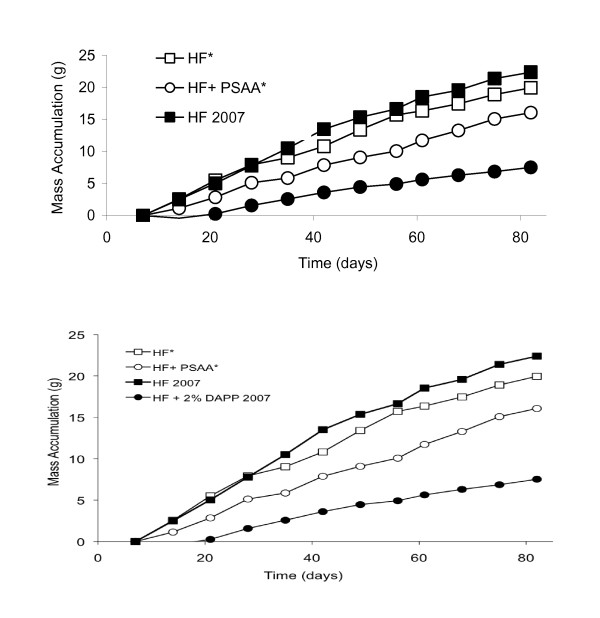
Mass accumulation of male C57bBl/6 mice exposed to a high fat diet with or without supplements. 1a) Animals in the phytosterol+ascorbic acid (PSAA) group exhibited a reduction in mass accumulation by week 2 and the difference became statistically significant by week 7 of the study (n = 7; ANOVA p < 0.05). 1b) Mass accumulation over time for C57Bl/6 animals consuming a high fat diet with ascorbic acid and phytosterol supplementation (this study) in comparison to animals consuming a high fat control diet with or without disodium ascorbyl phytostanyl phosphate(17). Mice chronically exposed to a high fat diet supplemented with 2% w/w phytostanol esterified with ascorbic acid show a greater decrease in mass accumulation than those consuming a high fat diet supplemented with unesterified phytosterols and ascorbic acid (1% w/w of each component). * indicates data obtained from this study.